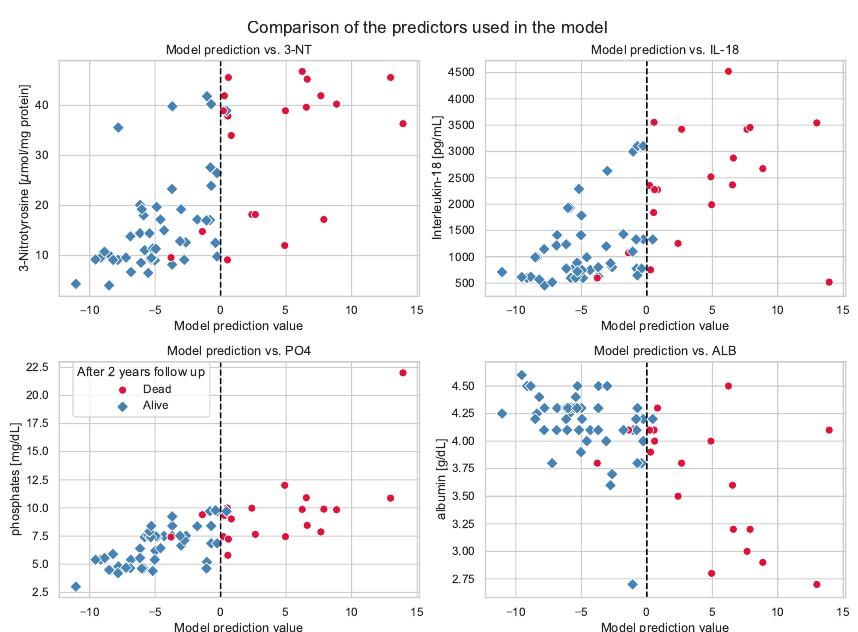
Figure 7. Visualization of the model results with respect to all the four chosen predictors. The HD-A and HD-D groups are marked with blue and red colors, respectively. The vertical dashed line represents a change in the predicted fate of patients (the negative value of the model prediction can be treated as predicting that a patient will survive in the next 2 years, but a positive value foreshadows the patient’s death).